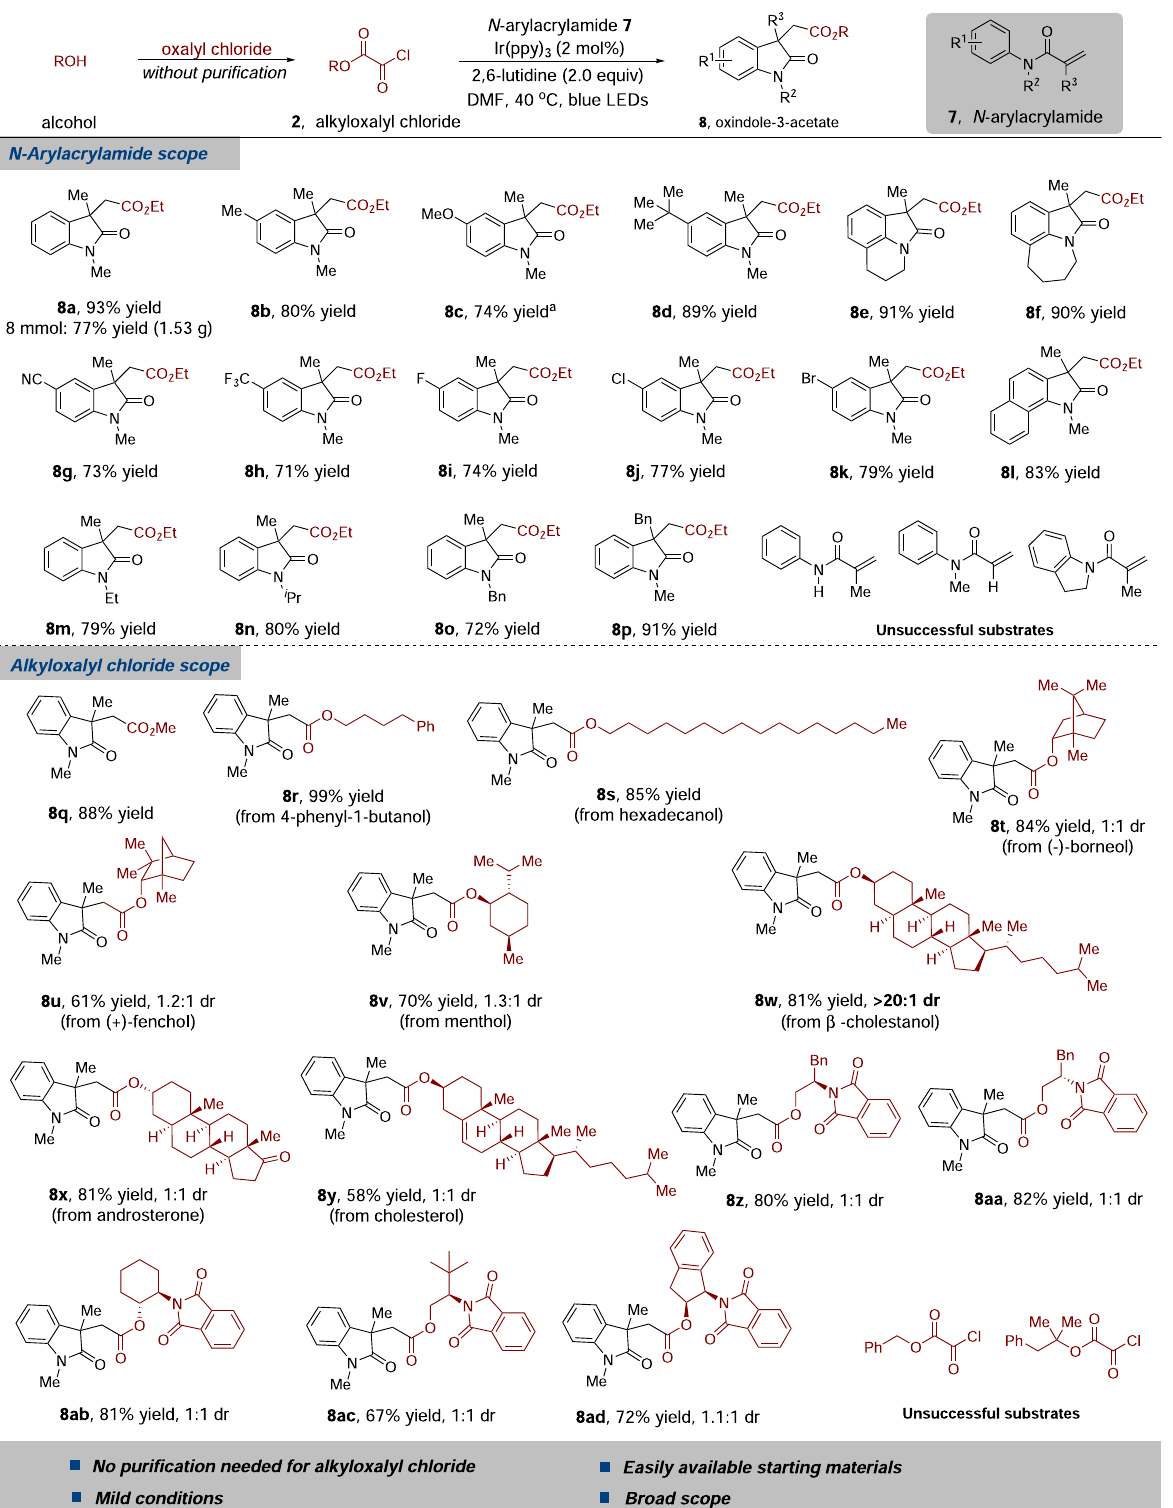
Fig. 5 From alcohols to oxindole-3-acetates: substrate scope of the alkoxycarbonylation/cyclization reaction. Reaction conditions: N -arylacrylamide 7 (0.2 mmol), alkyloxalyl chloride 2 (0.6 mmol), Ir(ppy) 3 (2 mol %), 2,6-lutidine (0.4 mmol), anhydrous DMF (4.0 mL), blue LEDs, 40 °C, 24 h, under N 2 atmosphere. Yield of isolated product. The dr values were determined by 1 H NMR analysis. a Reaction time: 48